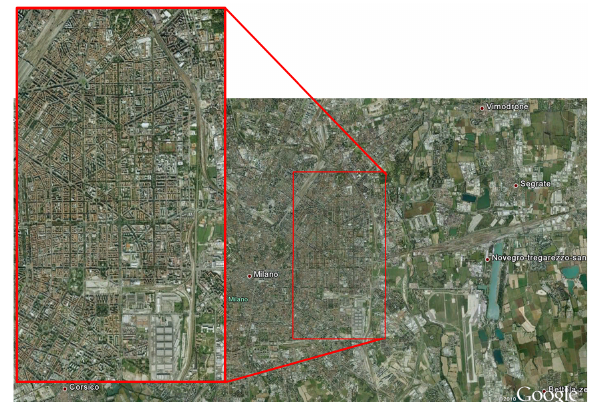
Figure 4: Test area in the Milano urban neighbourhood (red rect- angle).